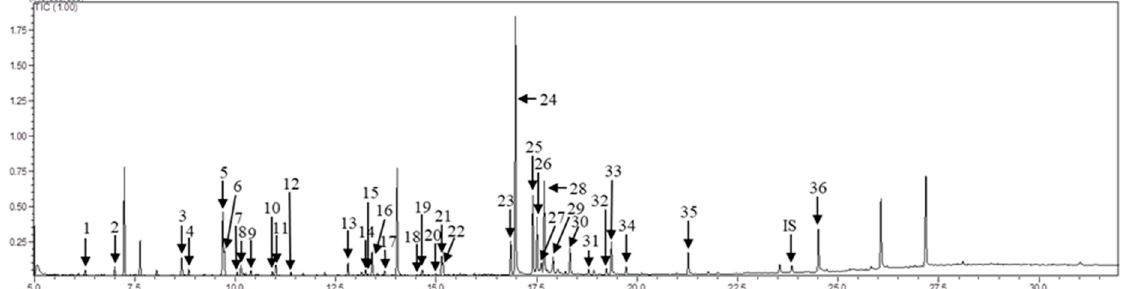
Figure 2. Quality control BPI chromatogram of ethylene untreated and treated soybean leaves extracts using GC-MS. 1 ,